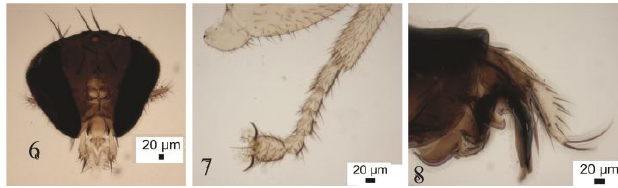
Figs 6-8. Problem damaged specimen, male. 6, frontal view of head; 7, front tarsus; 8, left face of